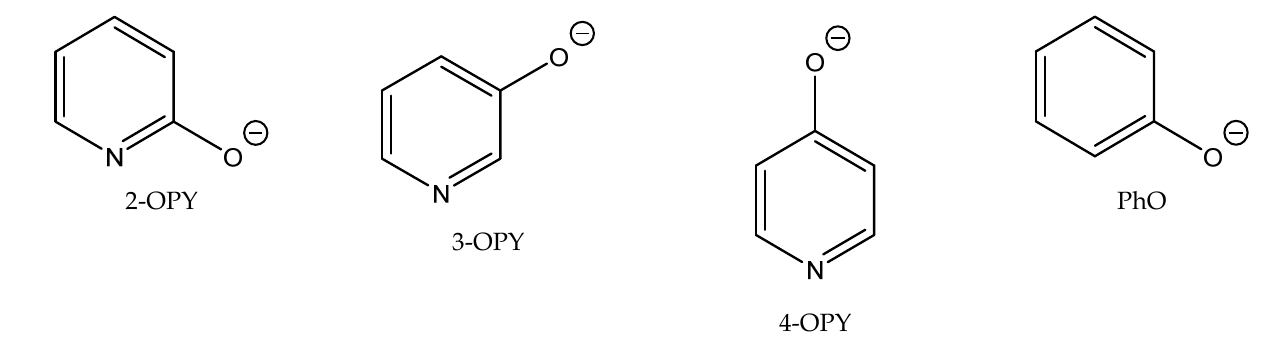
Figure 8. Structures of hydroxypyridine anion OPYs [69]. Table 14. Cycloaddition of CO 2 with EPIC catalyzed ILs